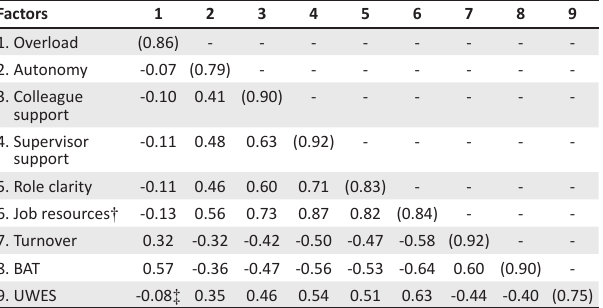
TABLE 4: Correlation matrix for the Job Demands–Resources model.